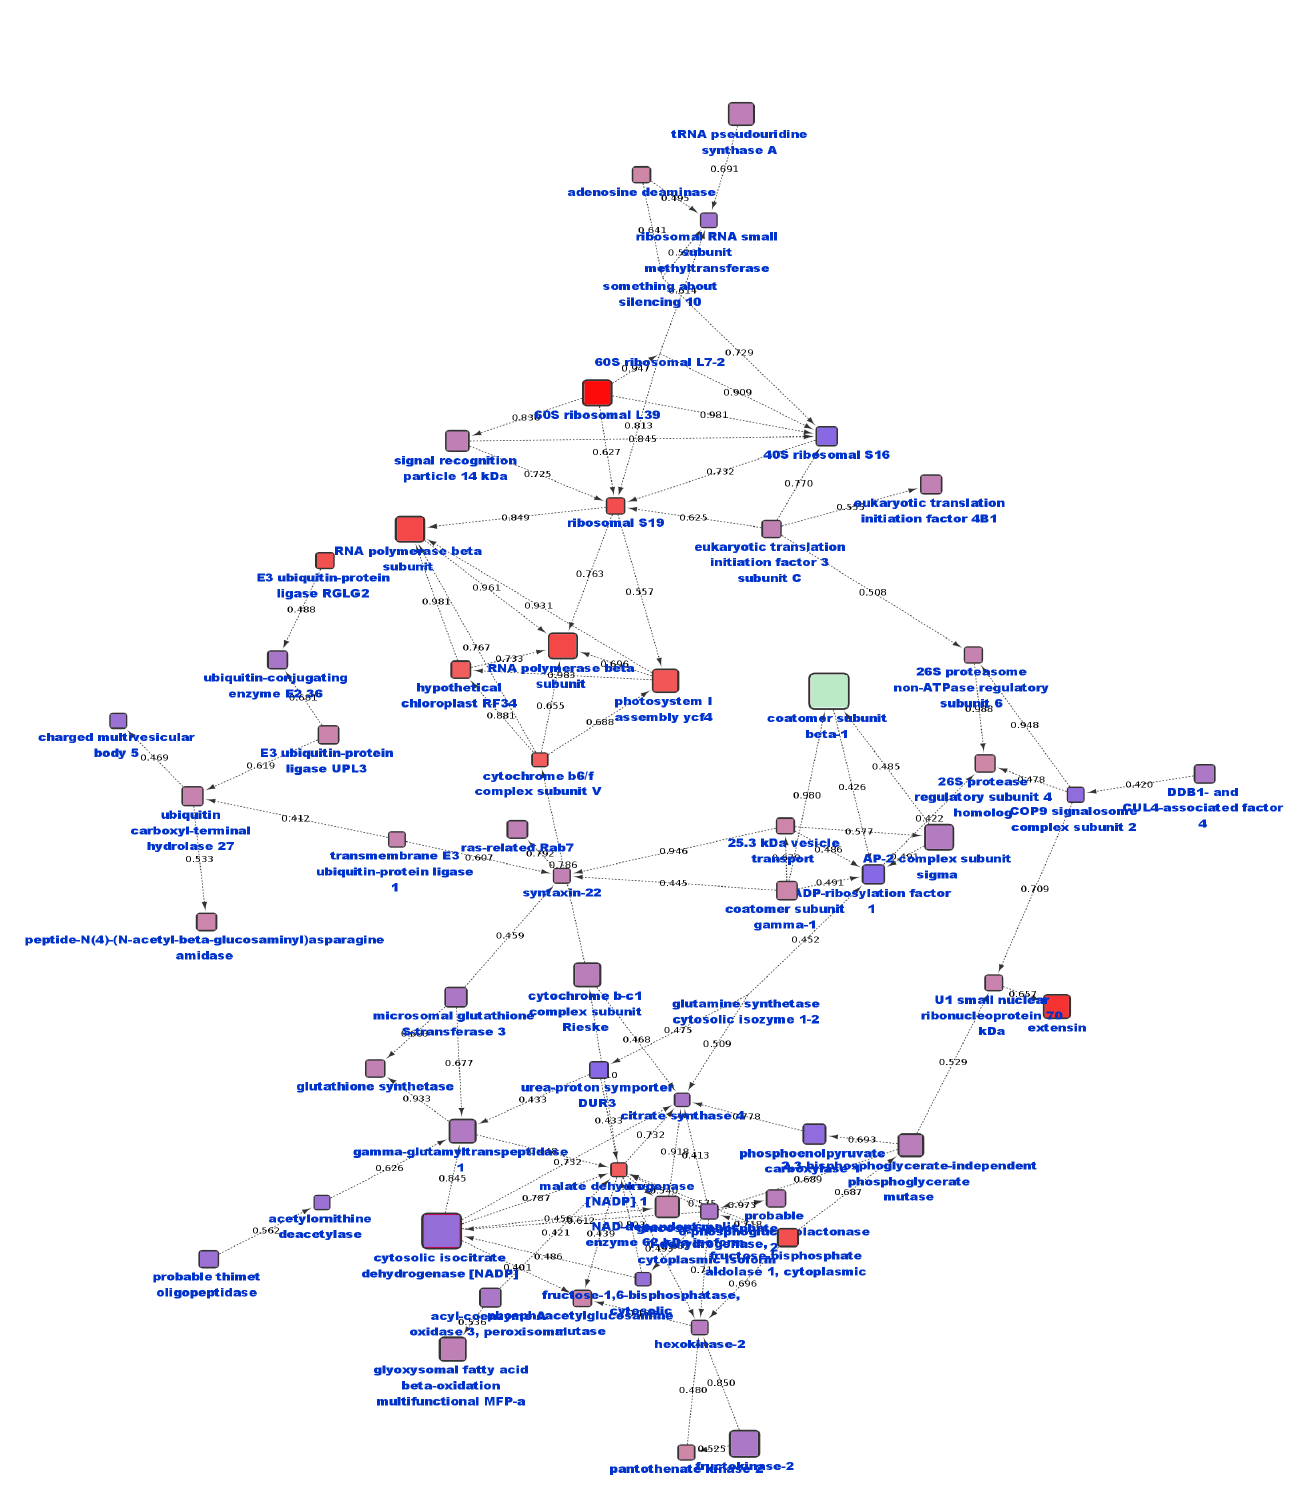
Figure 5. The protein-protein interaction networks of DEGs genes of HD.M gene profile. The node size and color stand for gene significance (log p value) and gene expression (LogFC)